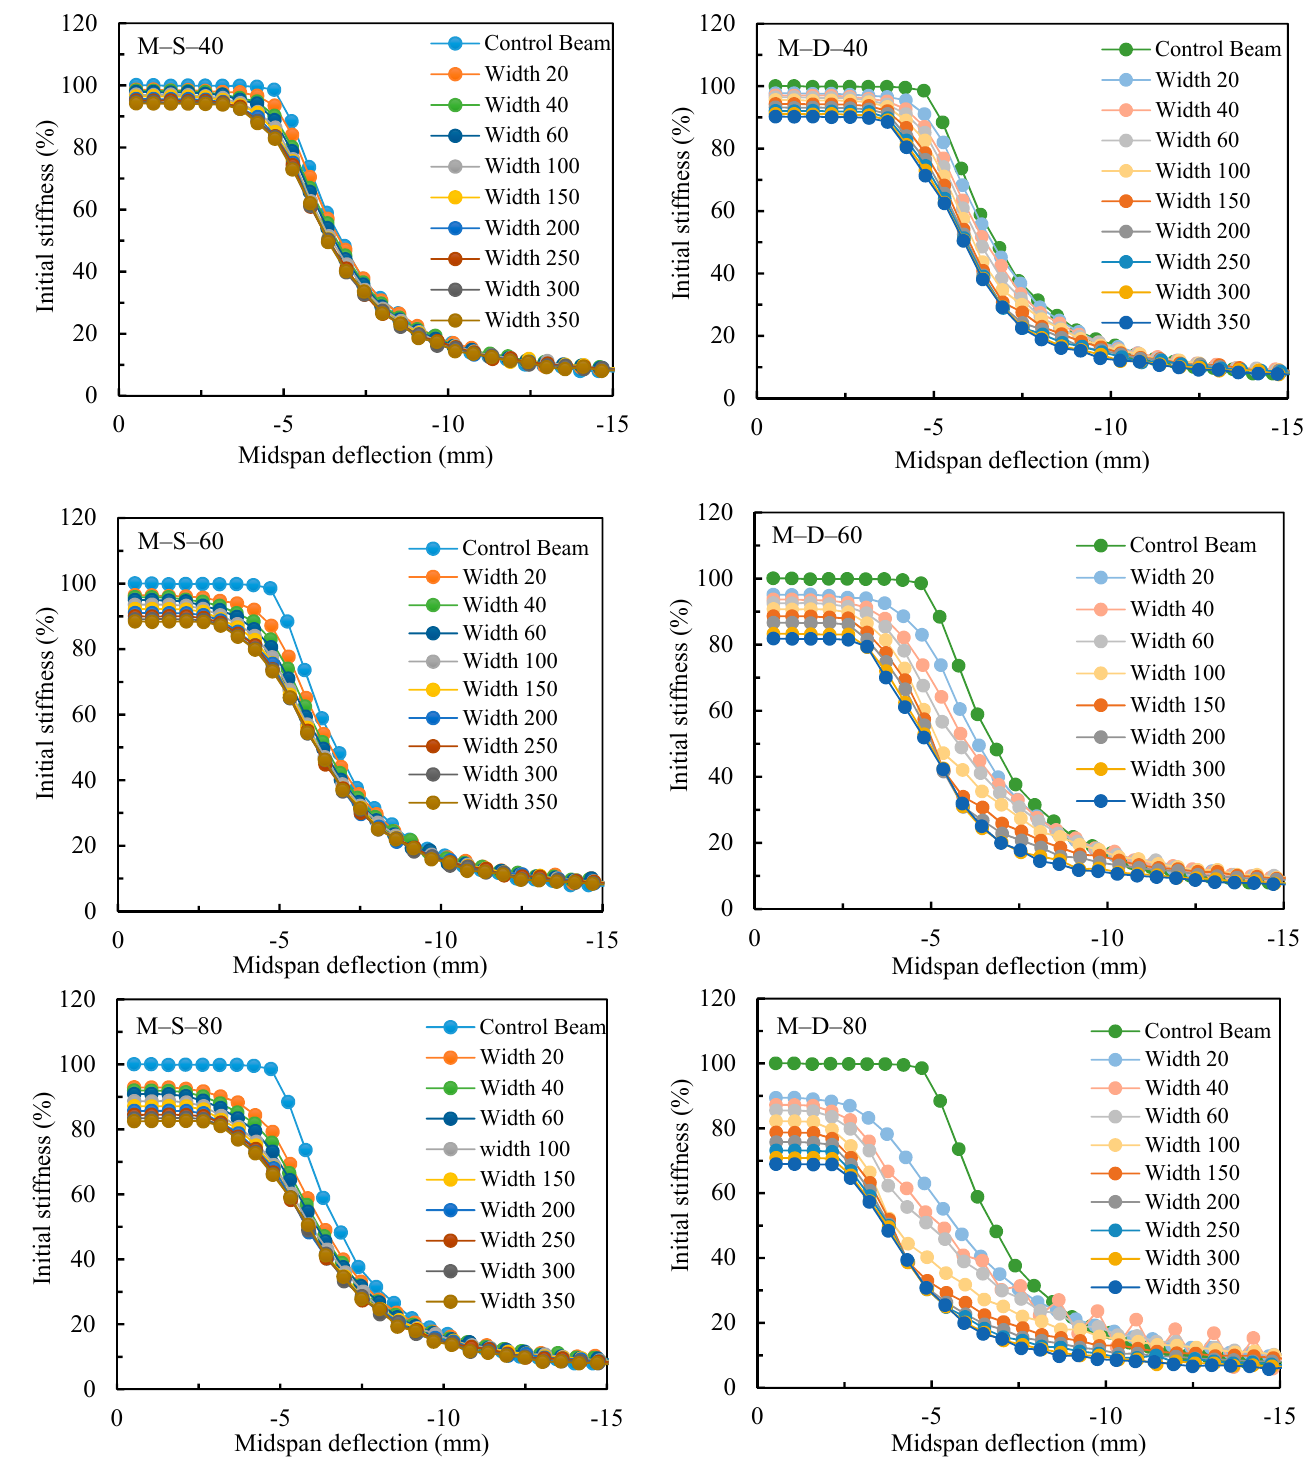
Figure 15. Numerical stiffness–midspan deflection relations of control and damaged beams.